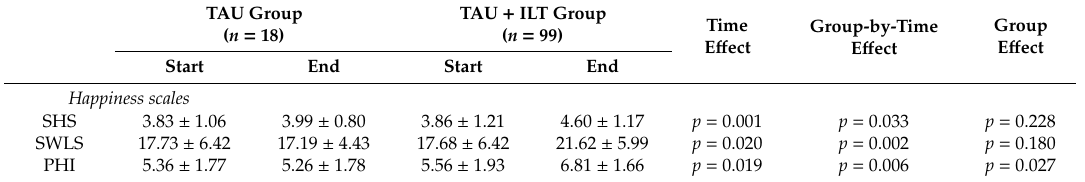
TAU + ILT Group Group Group-by-Time ( n = 99) Time E ff ect E ff ect E ff ect